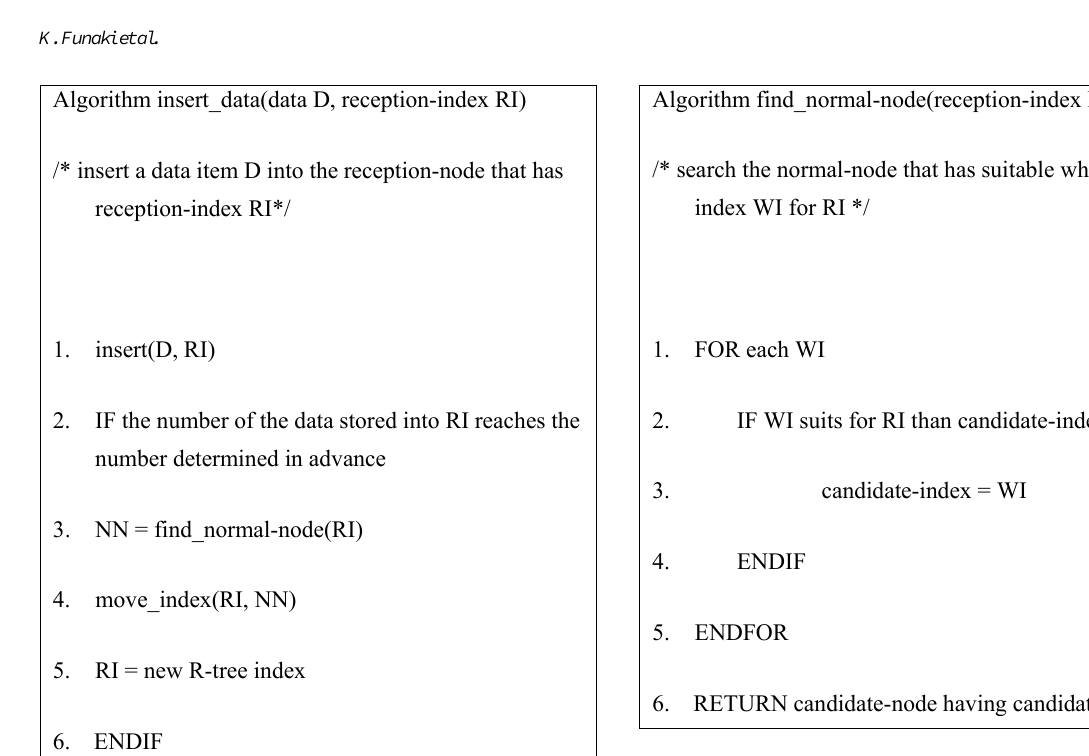
Fig. 4. The algorithm of finding a normal node.